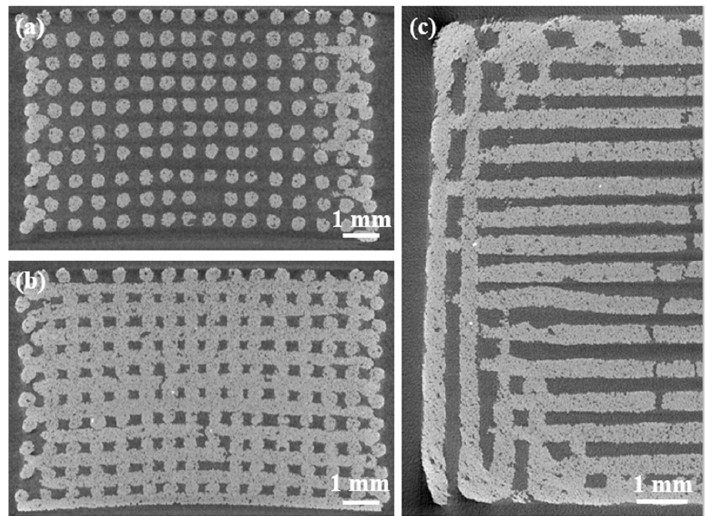
Figure 4. Microcomputed tomography (µCT) investigation of the scaffold structures: ( a ) cross-section on a plane passing through the gap between horizontal rods (struts); ( b ) cross-section on a plane